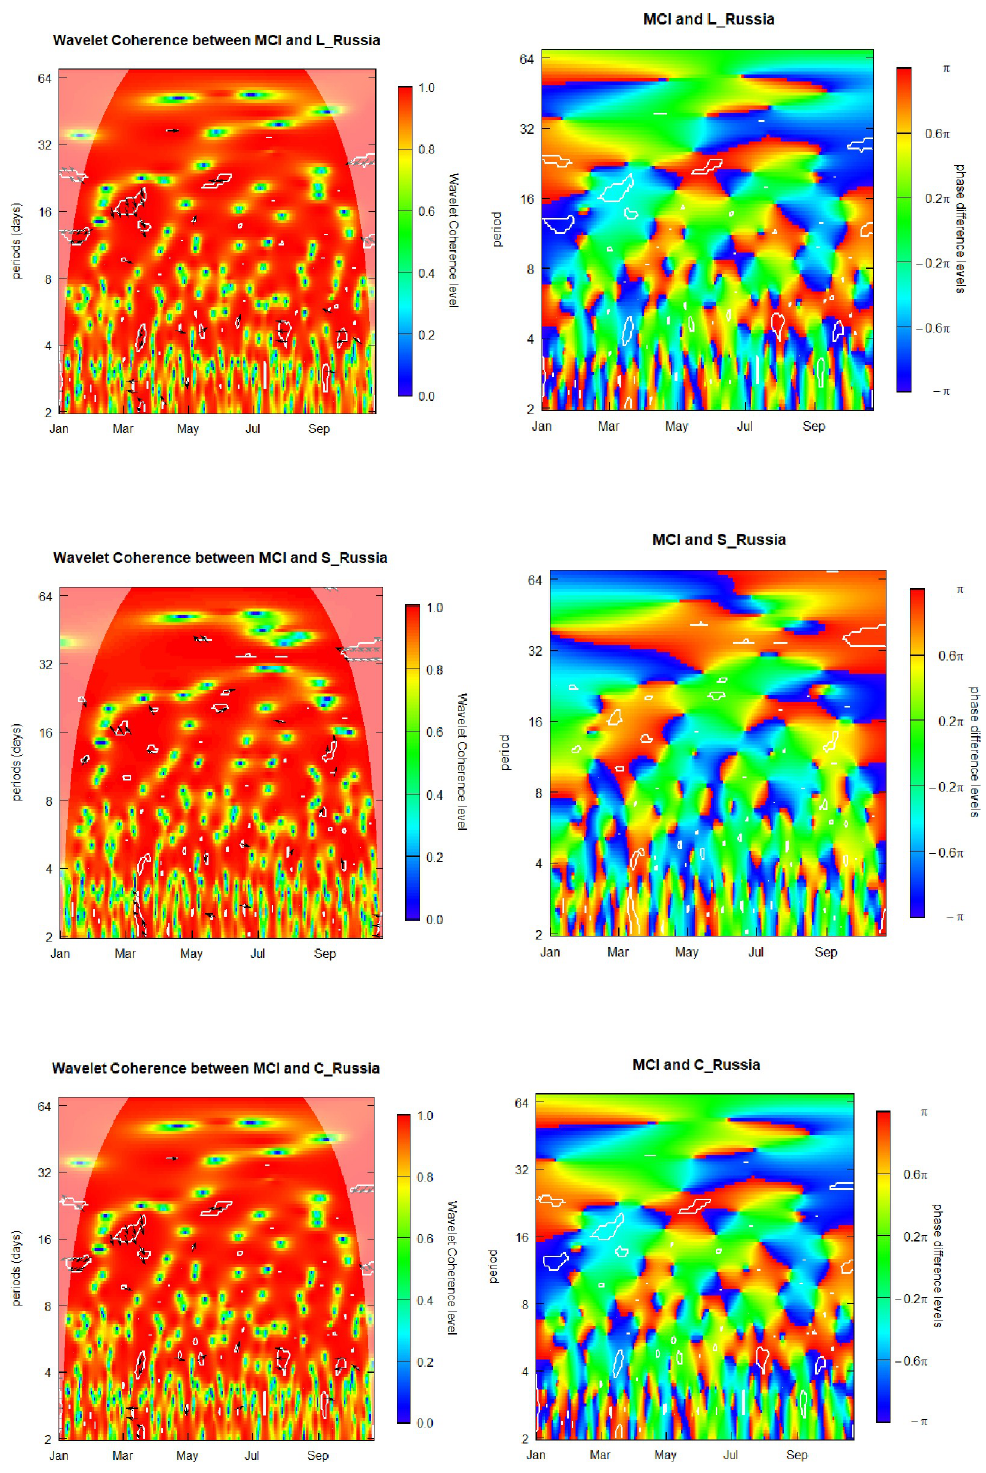
Fig 2. Media Coverage Index (MCI) and sovereign yield components of Russia. L_Russia, S_Russia, and C_Russia denote the level, curvature and slope component for Russia.